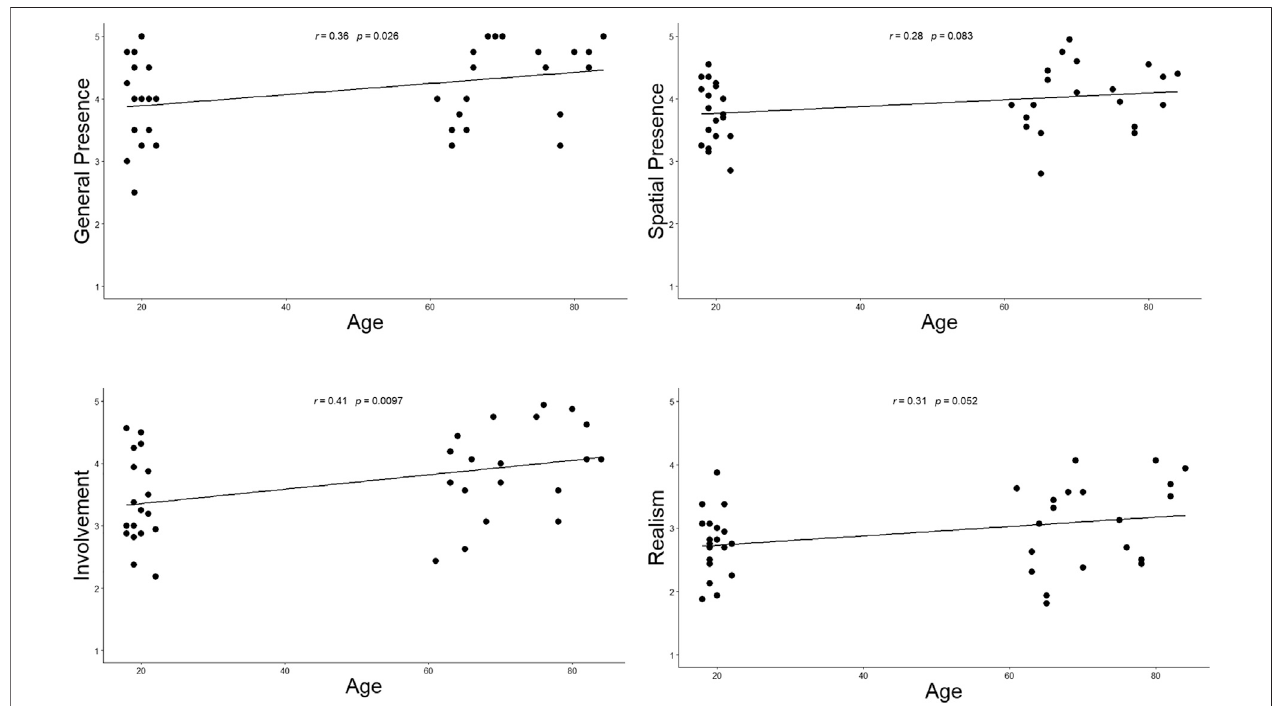
FIGURE 2 | Scatter plot depicting the relationship between presence measures (averaged across experiences) and age. As one younger adult did not report their age, N (cid:1) 19 younger adults, 20 older adults.